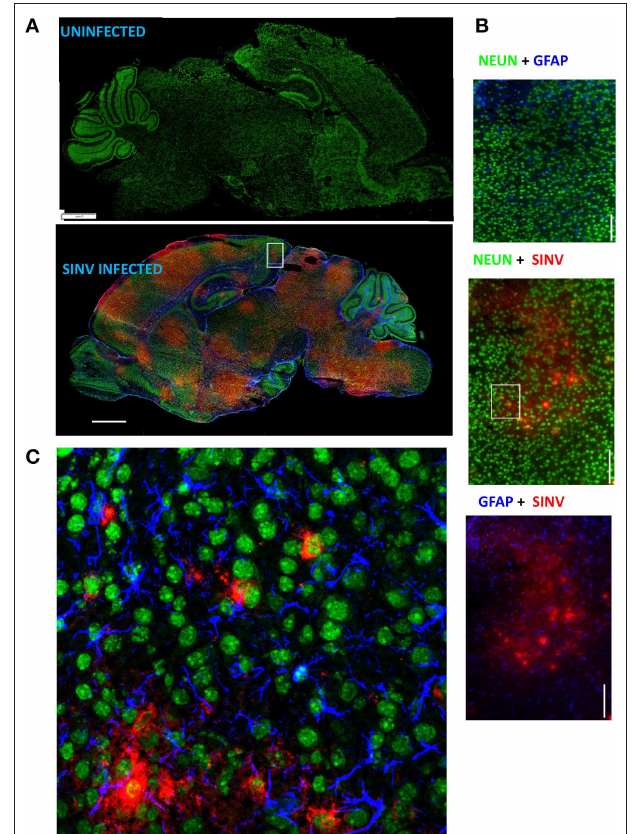
FIGURE 2 | SINV infects neurons. (A) Representative images of infected and uninfected p8 (5 dpi) brains stained with NeuN (neurons, green), GFAP (astrocytes, blue), and SINV (rabbit anti-SINV polyclonal antibodies and goat anti-rabbit-PE secondary antibodies, red). Note that broad virus distribution spares cerebellum cortex and olfactory bulb. Scale bar = 1mm. (B) Magnified image (60 × ) of the region represented by the white box in (A) is shown in these panels scale bar = 100 microns. (C) Confocal image of the outlined region using the same antibody panel confirming the infection of neurons by SINV. Scale bar = 50